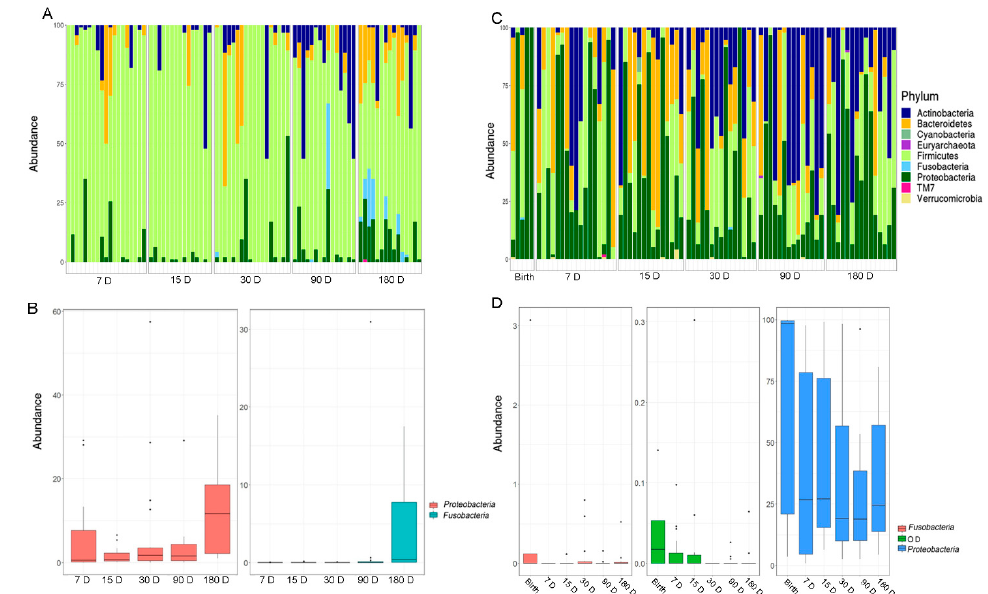
Figure 2. ( A ) The OTUs distribution of the salivary microbiota at the phylum level. ( B ) The histograms refer to the Kruskal–Wallis test-based phyla distribution with a p FDR < 0.05 in the salivary samples. ( C ) The OTUs distribution of the gut microbiota at the phylum level. The bar graphs represent the average distribution of the OTUs. ( D ) The histograms refer to the Kruskal–Wallis test- based phyla distribution with a p FDR < 0.05 in stool samples. D, days.